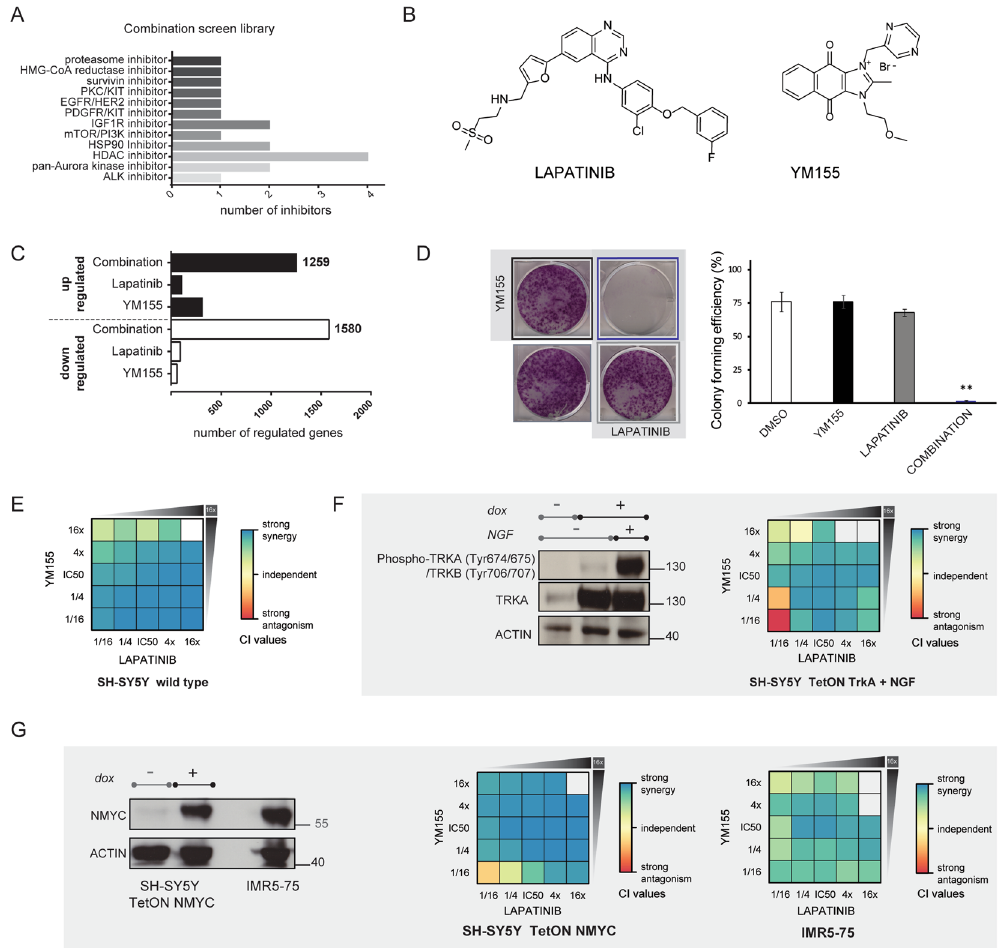
Figure 1. YM155 and lapatinib show high degree of synergy in neuroblastoma regardless of the MYCN and TRKA status. ( A ) Overview of the drug library used in the concentration matrix-based combination screen. ( B ) Chemical structures of lapatinib and YM155. ( C ) Microarray-based gene expression profiling. Bar graphs are showing the number of significantly upregulated and downregulated genes in each condition. ( D ) Colony formation assay; YM155 (black border) was used at 1/16 IC50 concentration (15 nM), lapatinib (gray border) at 1/8 IC50 (1 µ M). Combination treatment (blue border): 15 nM YM155 and 1 µ M lapatinib. DMSO (no border) treated cells were used as a control. Data shown as mean ± s.e.m. and images are representative of three individual experiments (ANOVA, ** P < 0.01). ( E ) Heatmap of CI values in the YM155 and lapatinib combination matrix, indicating a strong synergistic interaction. Data represent the mean of triplicates. ( F , G ) Synergistic effect is preserved in NTRK1 and MYCN highly expressed state. ( F ) Left, overexpression and activation of TRKA signaling in SH-SY5Y; right, heatmap of CI values in the combination matrix; data represent the mean of triplicates. ( G ) Left, overexpression of MYCN in SH-SY5Y and levels of MYCN protein in the IMR5–75 MYCN amplified cell line; right, heatmap of CI values in the combination matrix; data represent the mean of